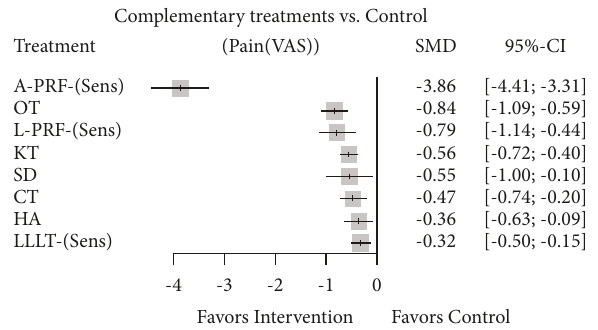
Figure 11: Forest plot comparing different complementary in- terventions for reducing early pain after third molar surgery after sensitivity analysis. A-PRF: advanced-platelet-rich fibrin; L-PRF: leukocyte-platelet-rich fibrin; SD: surgical drainage; CT: cryo- therapy; HA: hyaluronic acid; KT: Kinesio taping; LLLT: low-level laser therapy; OT: ozone therapy; Plc: placebo.